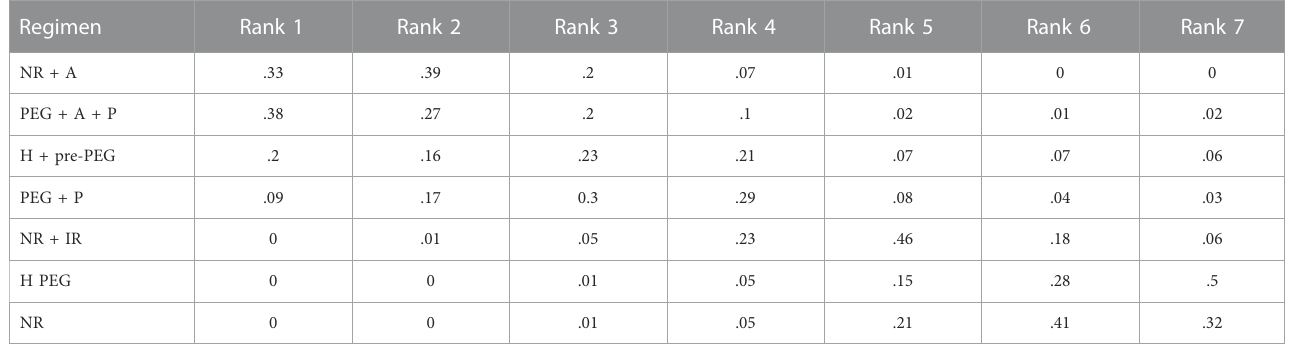
TABLE 3 Rank probability of bowel preparation regimens.